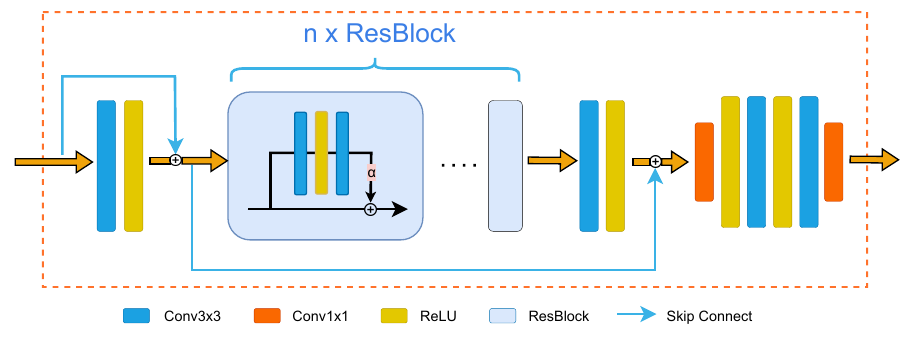
Figure 5. The structure of the decoder